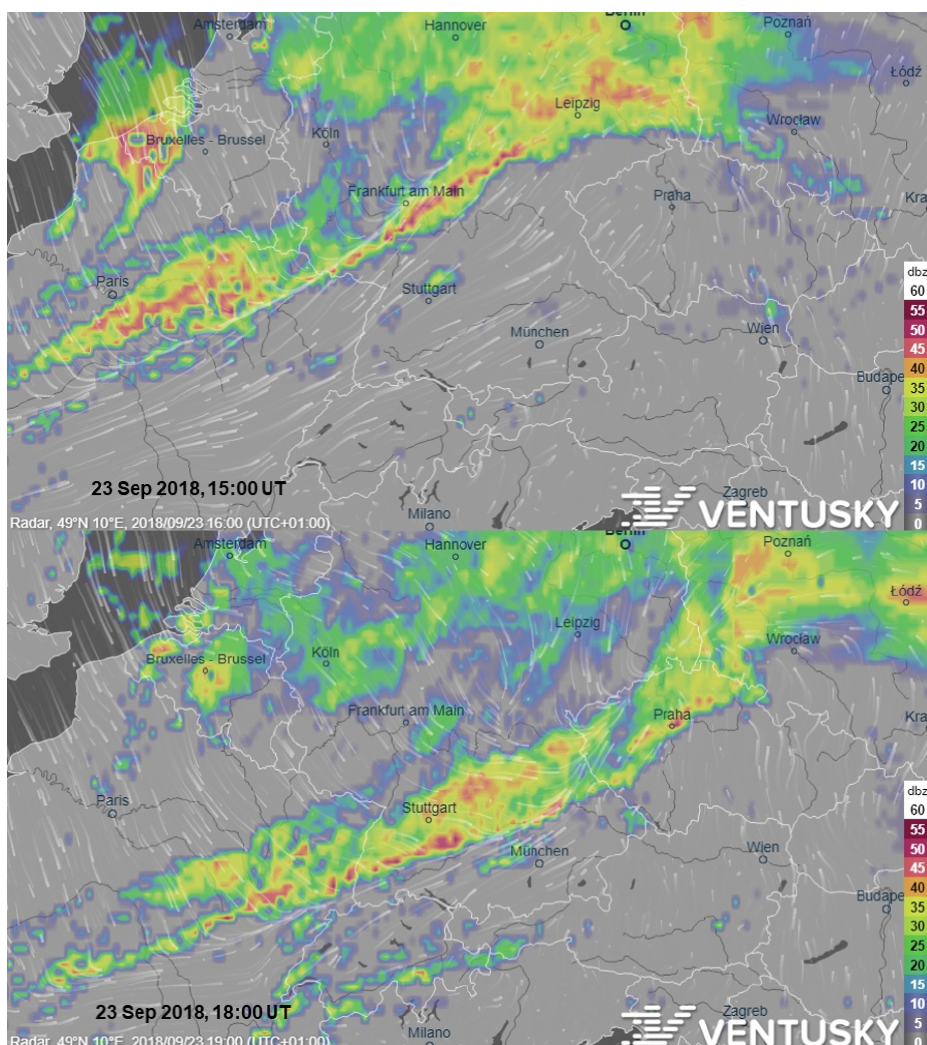
Figure 4. Horizontal maximum projection of radar reflectivity from the European radar provided by VentuSky (https://www.ventusky.com, last access: 3 October 2018). There is a rapid shift of the strong thunderstorms’ line (squall line) by 350km per 3h. White lines illustrate the wind speed at 10m above the ground. The color scale indicates the radar reflectivity in 5dBZ increments. The scale demonstrates the exponential dependence of the precipitation intensity (mmh − 1 ) on radar reflectivity (dBZ). The value of 55dBZ (dark purple) corresponds to the instantaneous value of the intensity of convective precipitation, 100mmh − 1